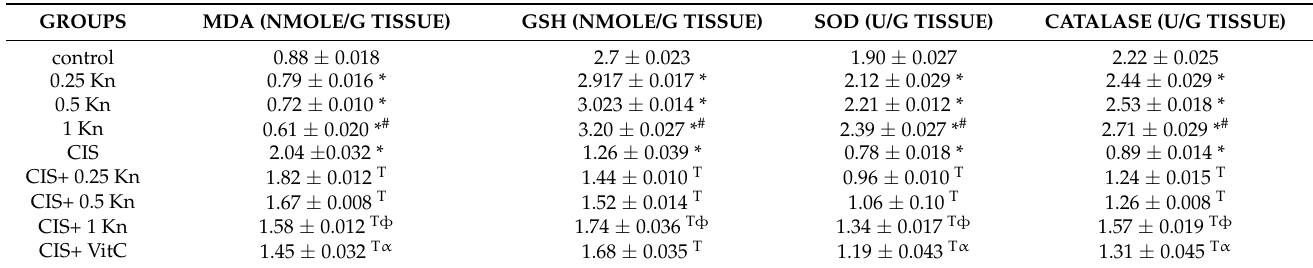
Table 1. Effect of different doses of kinetin and vitamin C on testicular content of malondialdehyde (MDA) and reduced glutathione (GSH) levels and activities of superoxide dismutase (SOD) and catalase activity in cisplatin-treated